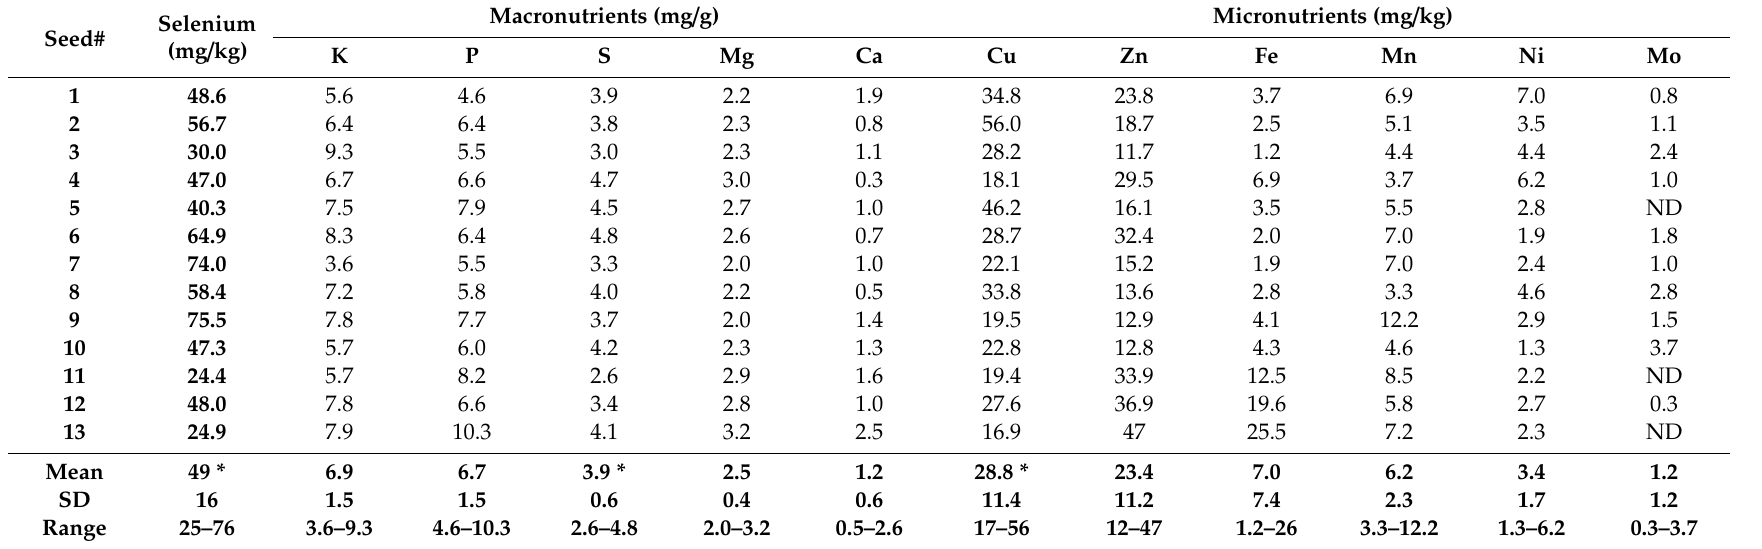
Table 1. Elemental composition of 13 commercially available Brazil nuts (Batch A), imported from